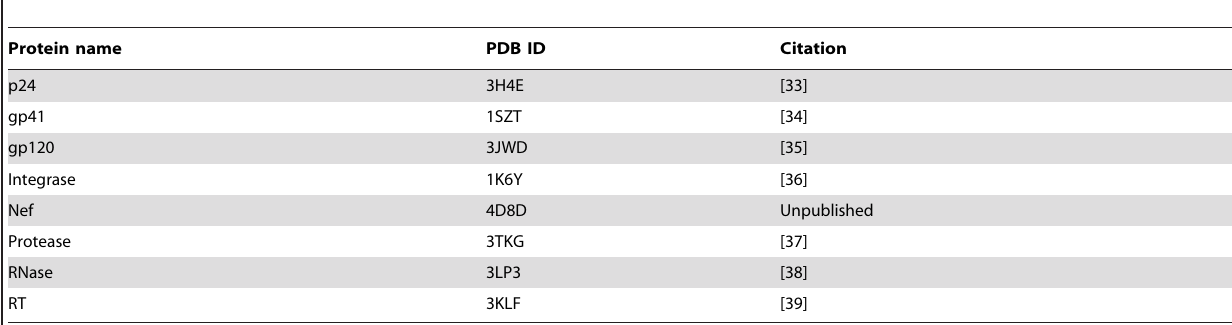
Table 1. List of PDB structure files used in the chimaeric protein-fold disruption tests.